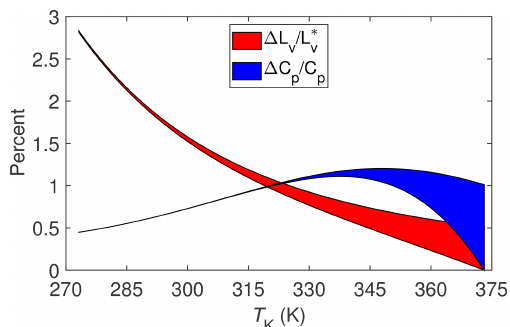
Figure 3. % change in C p from the sum of Eqs. (9) and (10) along with (overlaying) the results for (cid:49)L v /L ∗ v as shown in Fig. 2. The upper curve bounding the blue shaded area is (cid:49)C p /C p for a pro- cess occurring at constant volume, and the lower boundary is for an isobaric